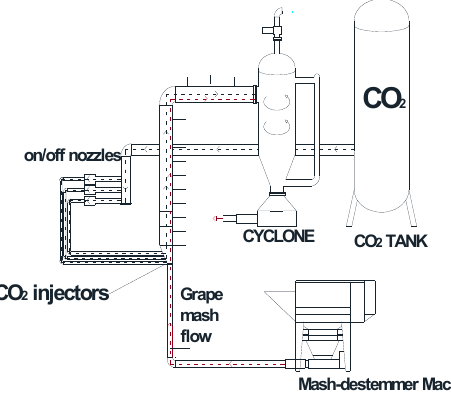
Figure 1. Grape cryomaceration equipment with liquid CO 2 .